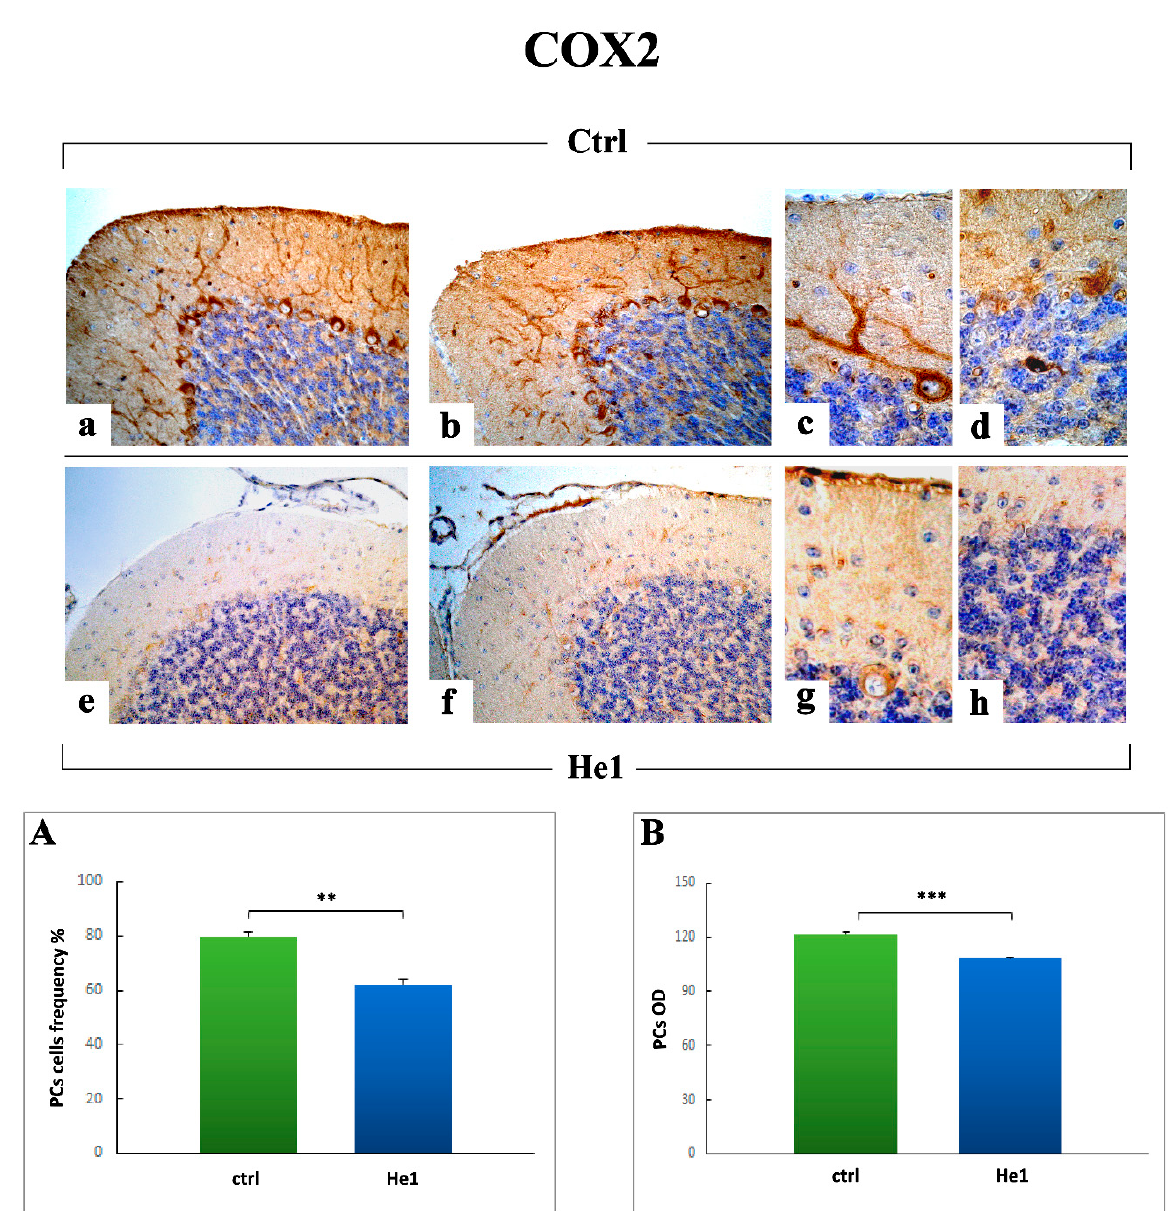
Figure 13. COX2 DAB-immunostaining reaction in untreated ( a , b ) and He1 mice ( c , d ). Light microscopy magnification: 40× ( a , c ); 100× ( b , d ). Panels ( A , B ) Histograms showing the quantitative determination of COX2 immunopositive cell frequency and OD. p values calculated by unpaired Student’s t -test: ** p < 0.01, *** p < 0.001.